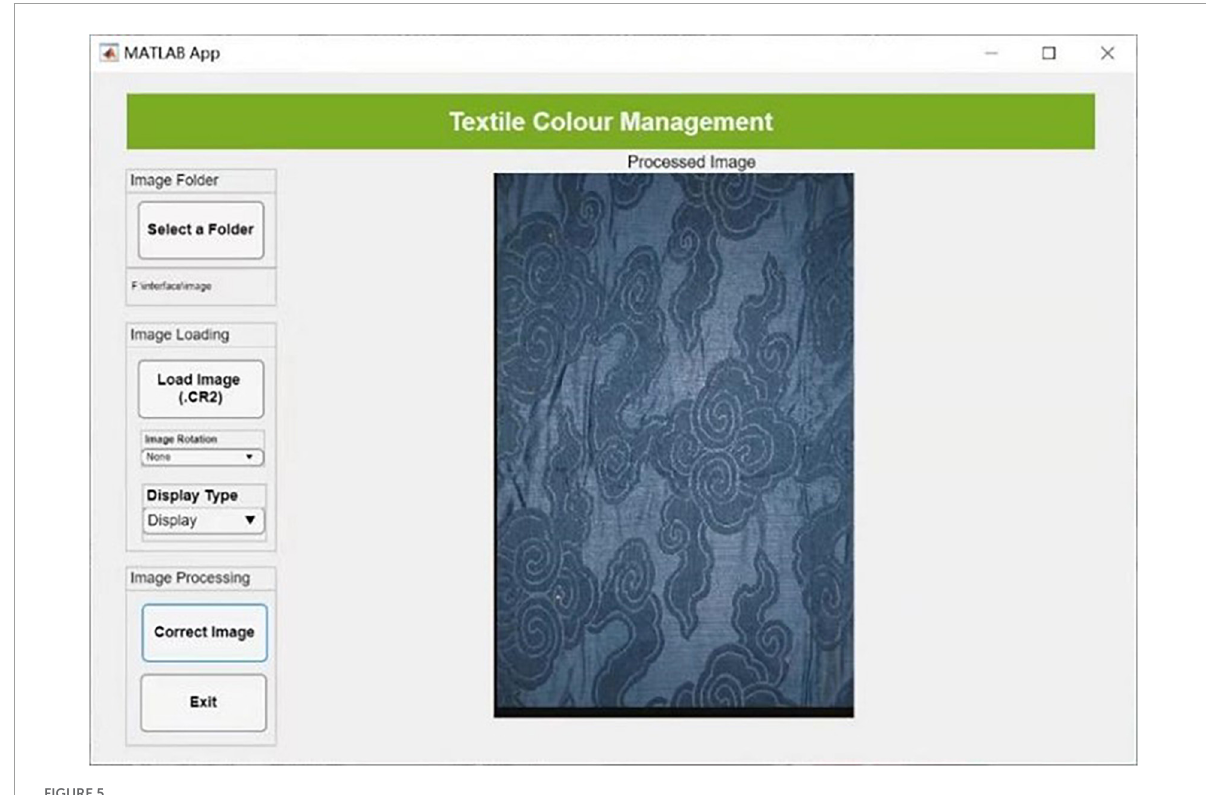
FIGURE5 The self-programmed graphic user interface for textile color management.